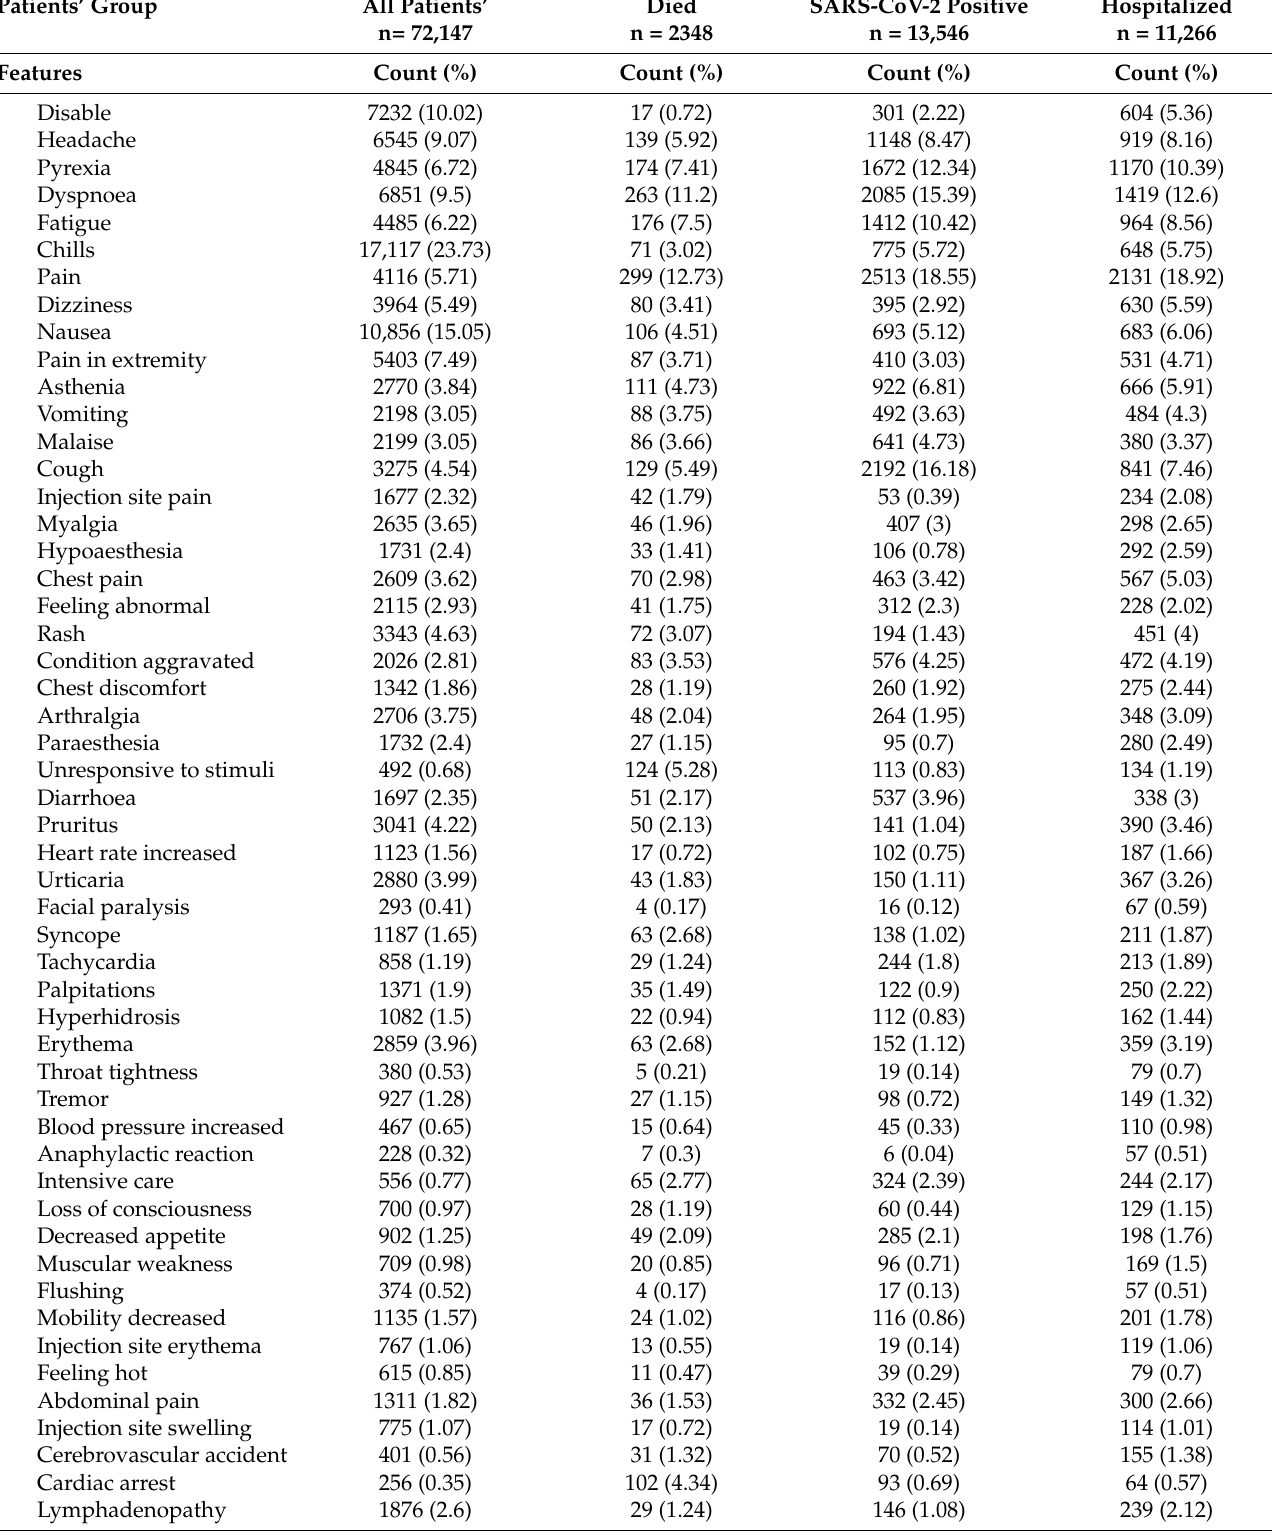
Table 2. The vaccination, demographic and patients’ medical